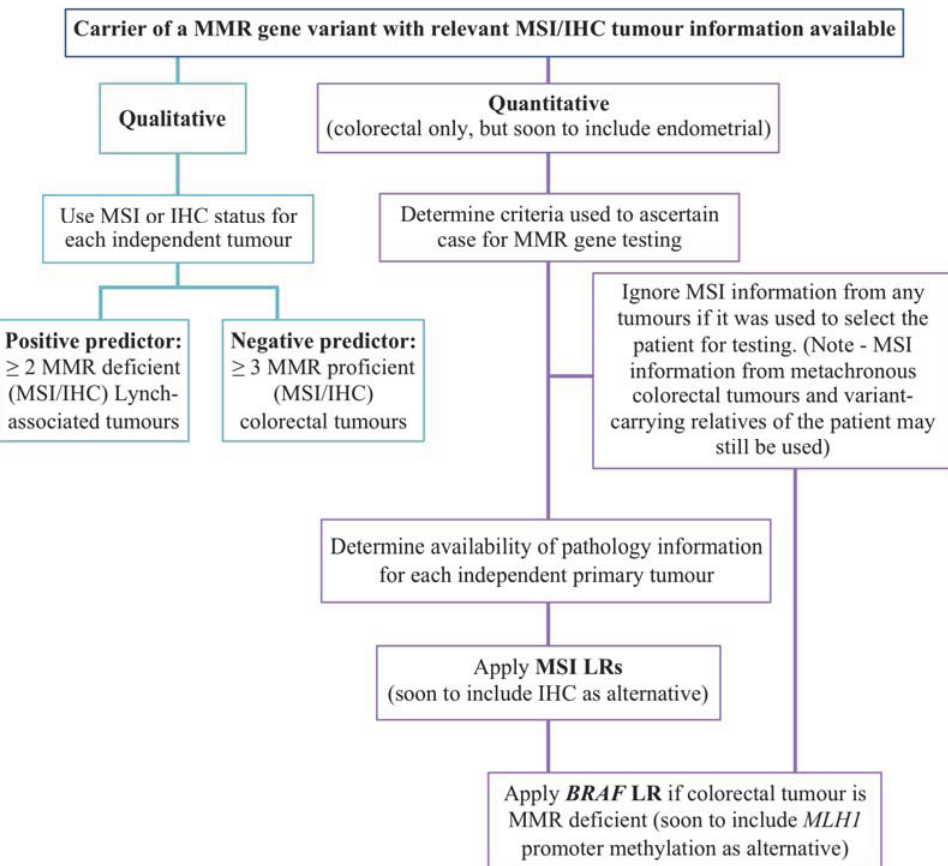
Figure 2. Flowchart of variant classification process using tumour features. MMR—mismatch repair; MSI—microsatellite instability; IHC—immunohistochemistry; LR—likelihood